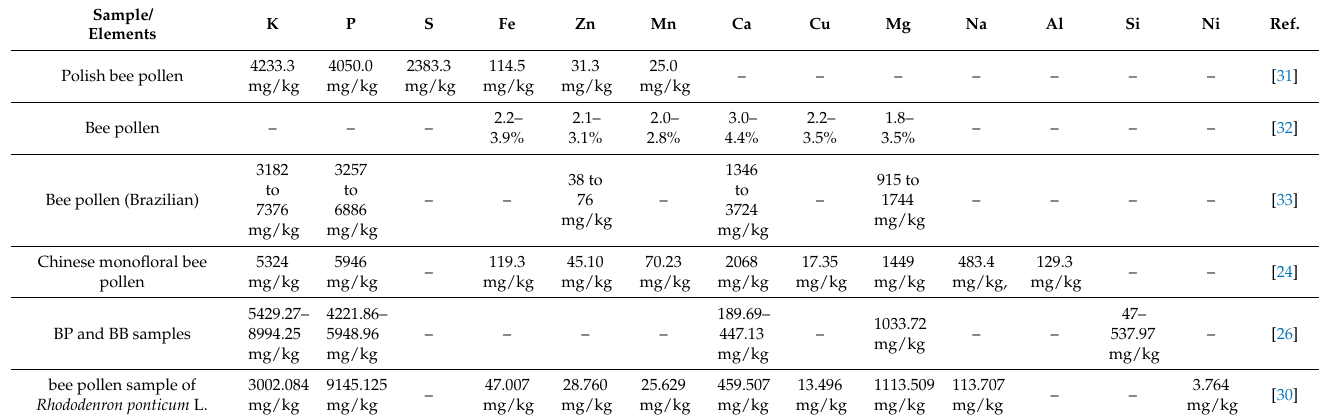
Table 3. Macro- and microelements detected in bee bread and bee